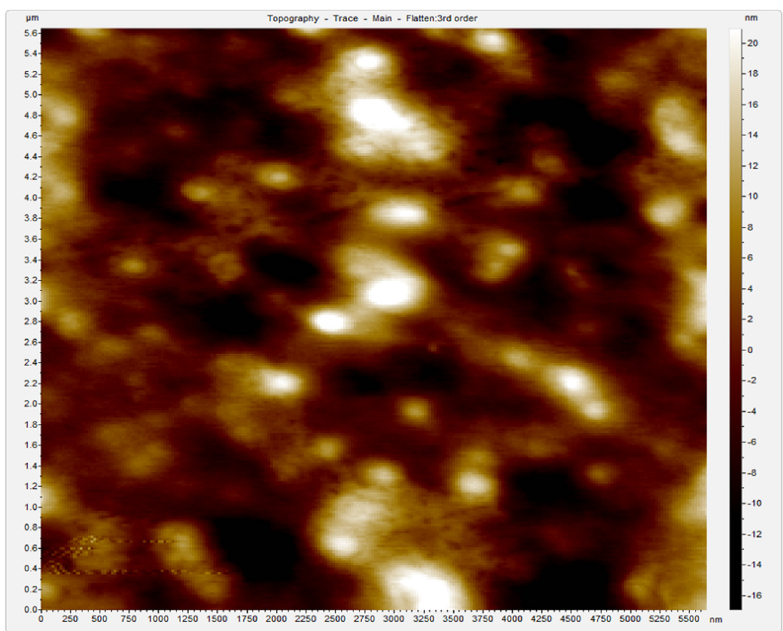
Figure 8: Showing circular and near - circular nanoparticles overlapping each